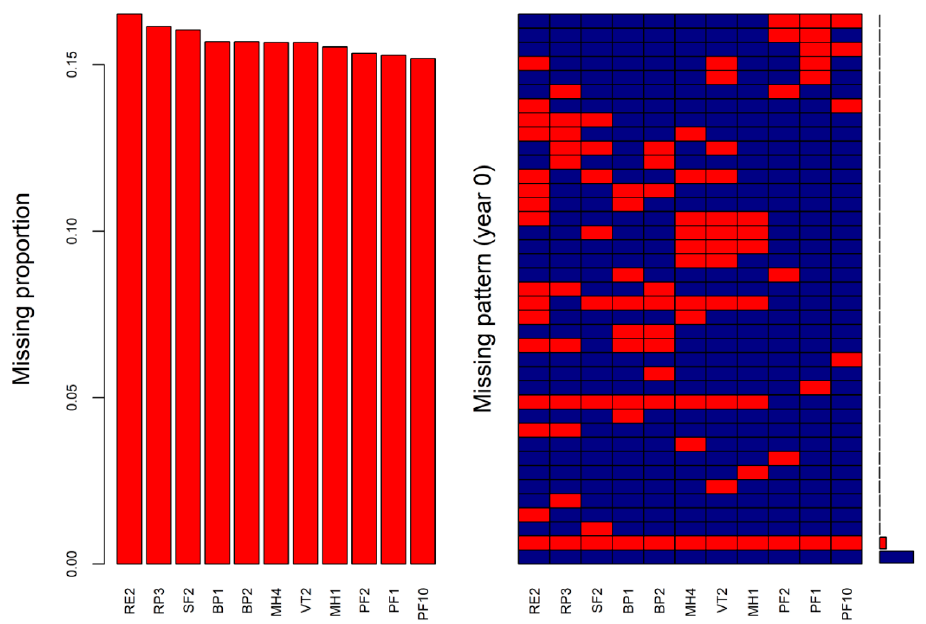
Figure 2. Simulated missing proportions ( left ) and missingness patterns ( right ) of the selected 11 SF-36 items at baseline in the analytical dataset (red cells indicating missing).